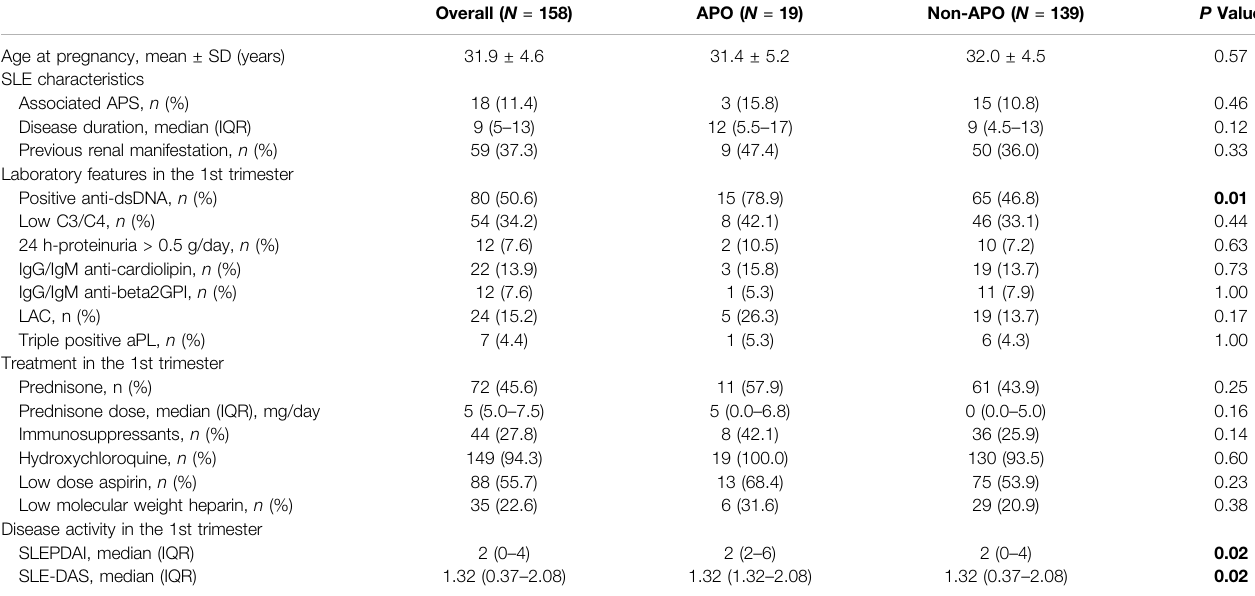
APO: adverse pregnancy outcome; SD: standard deviation; IQR: interquartile range; SLE: Systemic Lupus Erythematosus; APS: antiphospholipid syndrome; anti-dsDNA: anti-double strandedDNA;24 h:24 h;LAC:Lupusanticoagulant;aPL:anti-phospholipidantibodies;SLEPDAI:SystemicLupusErythematosusPregnancydiseaseActivityIndex;SLE-DAS:Systemic Lupus Erythematous disease activity score.